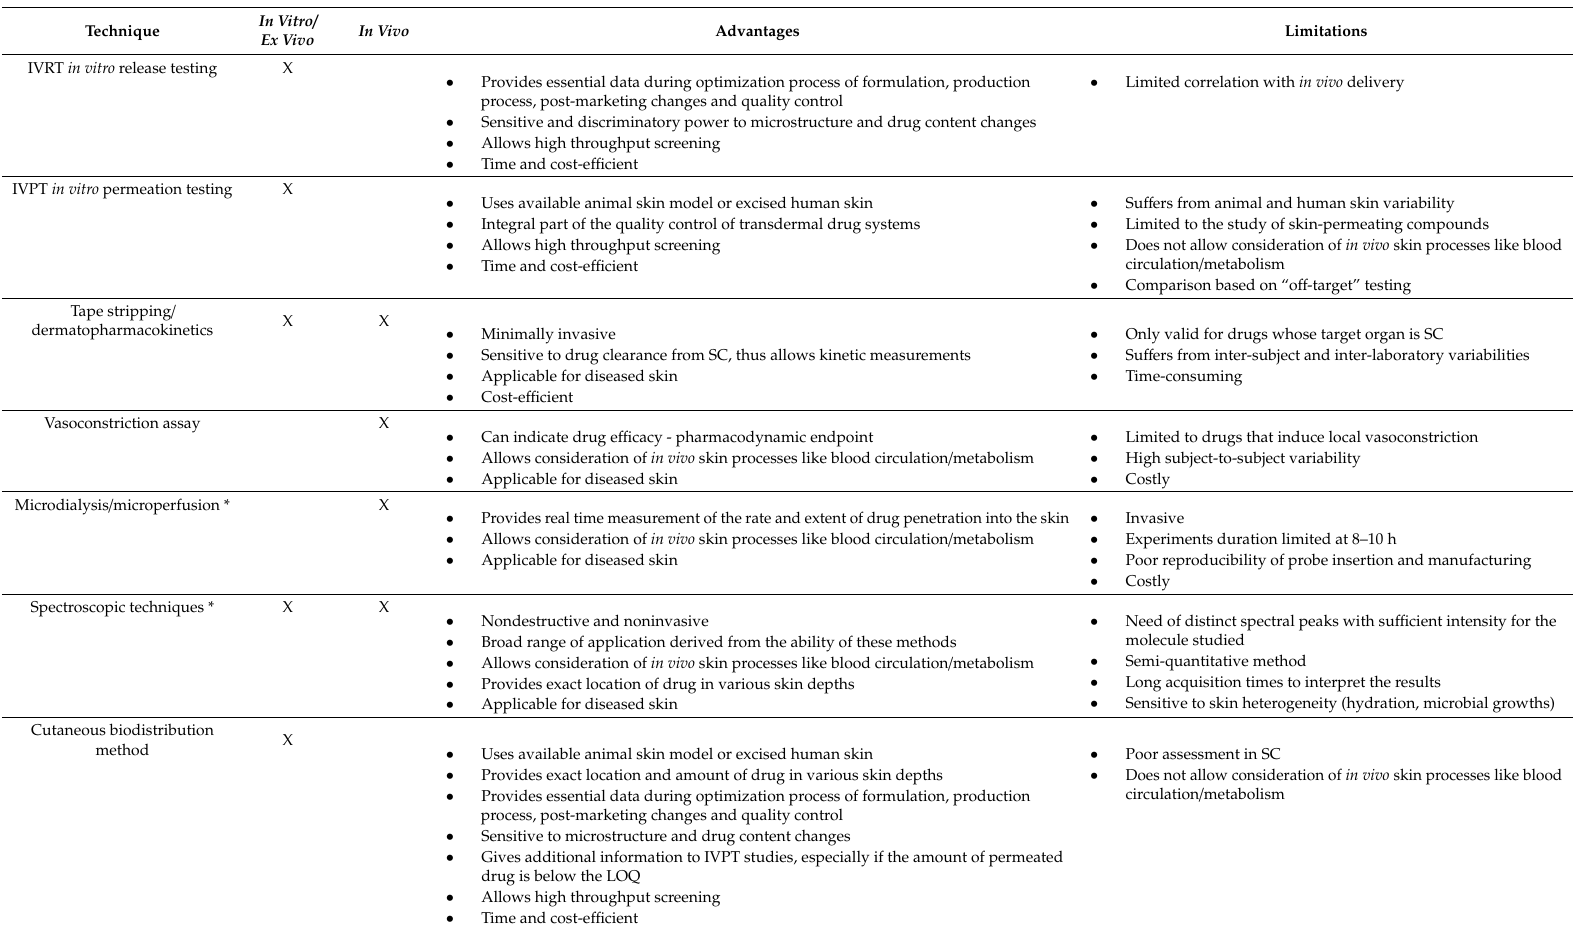
Table 4. Advantages and limitations of accepted / promising method and the proposed methodology to assess bioequivalence (adapted with permission from Patel et al. [23]. Copyright Elsevier, 2016.)